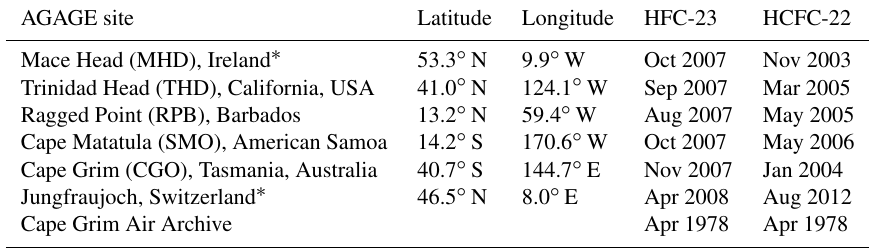
Table 1. AGAGE sites used in this study, their coordinates and start dates for GC-MS-Medusa measurements of HFC-23 and HCFC-22. AGAGE site Latitude Longitude